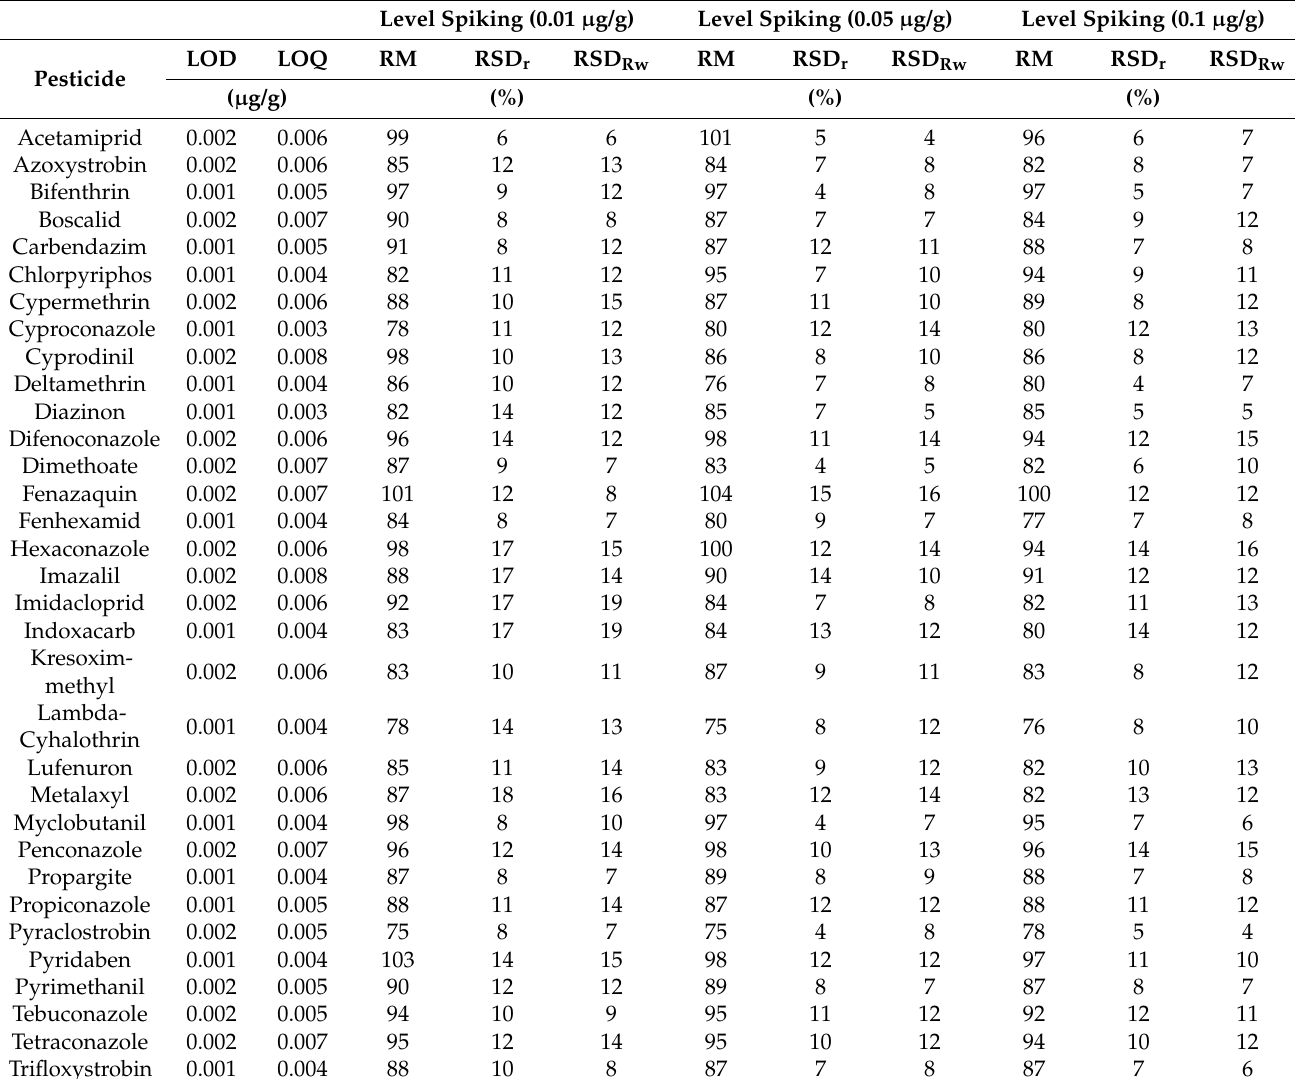
Table 1. Average of recovery data (RM%), repeatability (RSD r %) and reproducibility (RSD Rw %) for the 33 pesticides at the three fortification levels, 0.01, 0.05 and 0.1 µ g/g (n = 5 at each